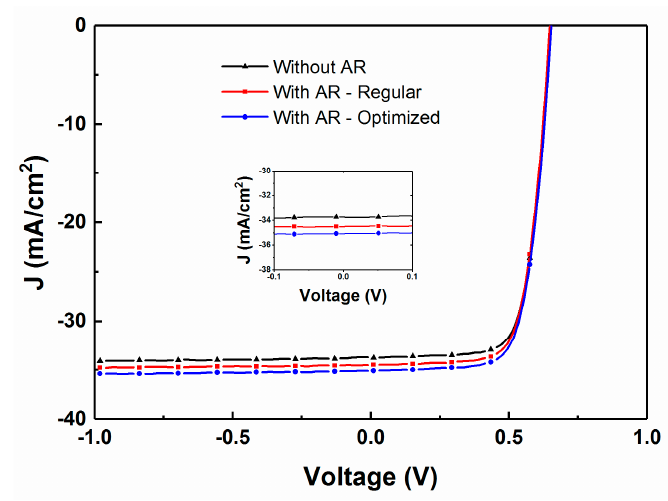
Figure 12. Measured J–V curves for CIGS solar cells with a 30 nm thick CdS layer and either no AR coating, a 118 nm prior modeled AR coating thickness, or a 110 nm in-situ optimized AR coating thickness (insert: close up of the − 0.1 V to 0.1 V zone).